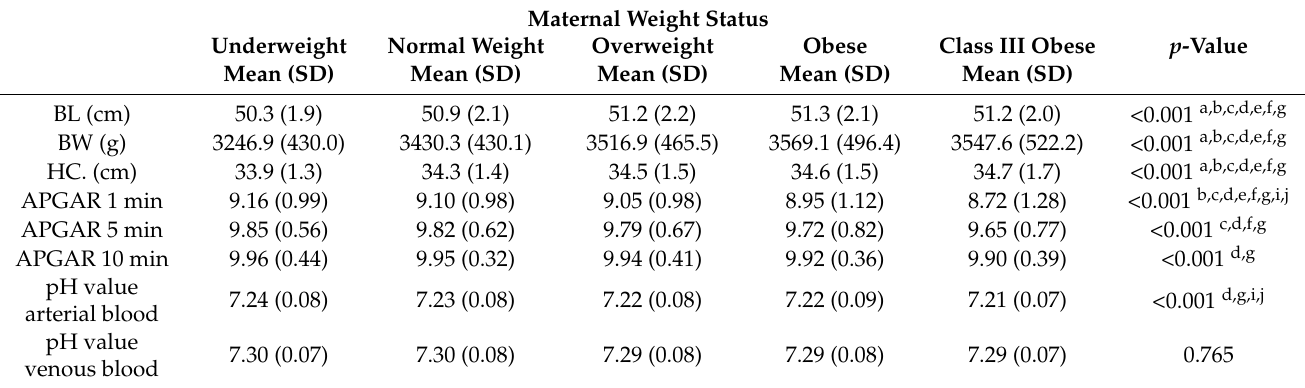
Table 4. Newborn parameters according to maternal weight classes Kruskal–Wallis H test (and Bonferroni corrections) and comparison of significance